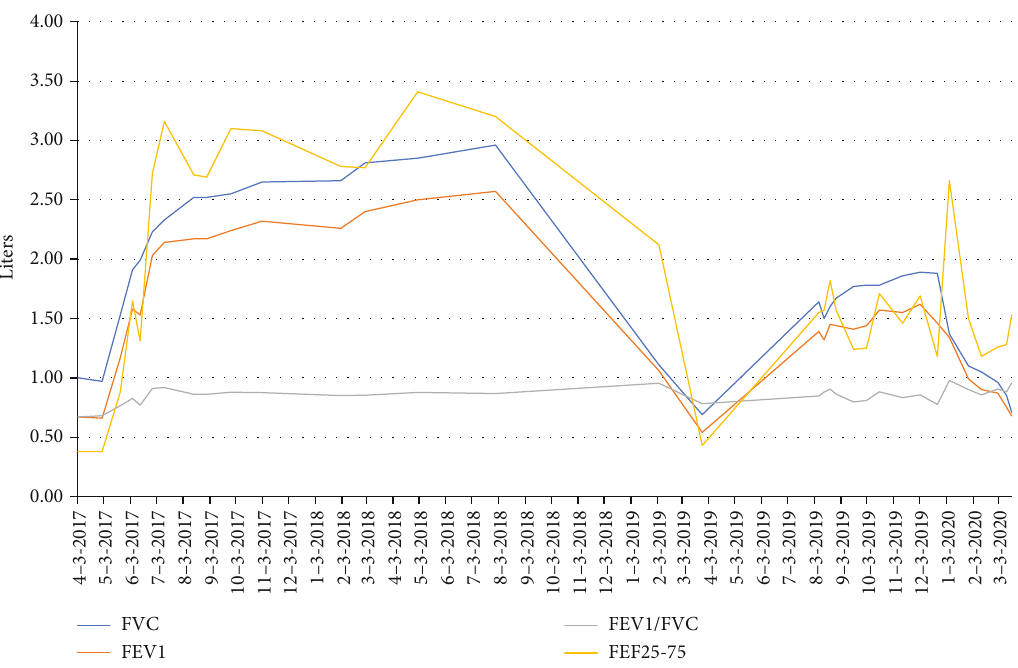
Figure 2: Posttransplant pulmonary function. FEV1: forced expiratory volume in one second; FEV1/FVC: forced expiratory volume in one second/forced vital capacity ratio; FEF25-75: mid-expiratory fl ow rate; FVC: forced vital